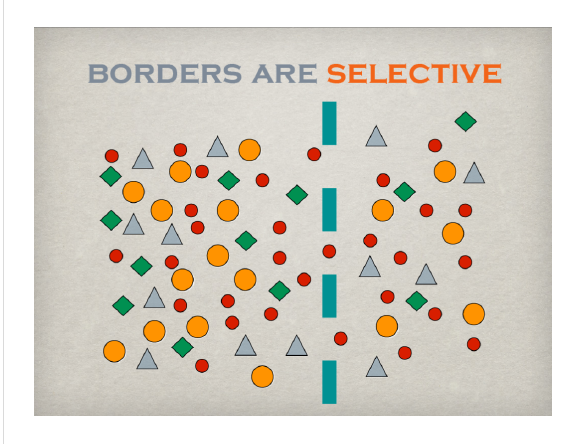
Figure 11: Depending on new developments, or changes in percep- tion the selection criteria and, as a result, the permeability of the border may change